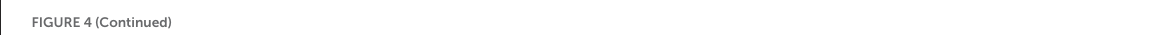
TABLE 4 Quantitative analysis of regions of interests in wake and DOC groups.